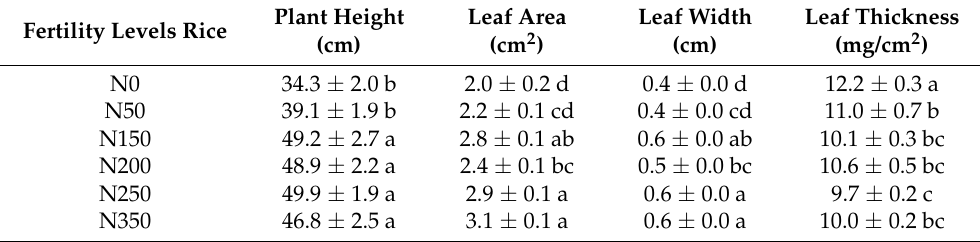
Table 5. Responses of rice physical parameters to nitrogen fertilizer application. Plant Height Leaf Fertility Levels Rice (cm)